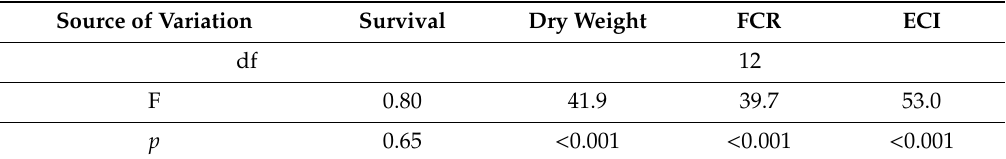
Table 4. Results of a one-way